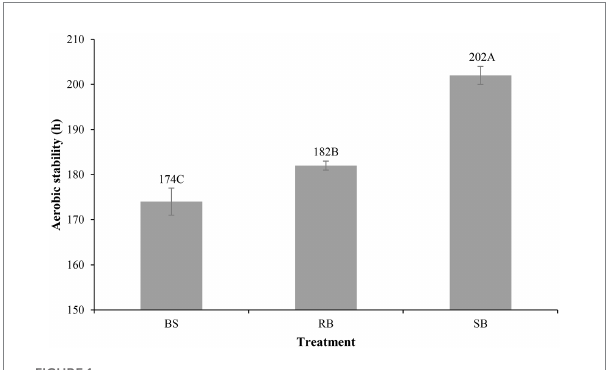
FIGURE 1 Effect of different ensiling methods on the aerobic stability (h) of WPCS after 90 days of ensiling (SEM = 1.247, p < 0.001). Vertical bars are the standard errors of the means, bars with different letters differ ( p < 0.05). Treatment: BS, Bunker silo; RB, Round bale; SB, Silage bag.